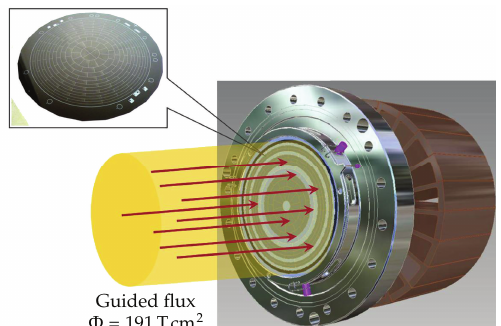
Figure 24: Schematic view of the detector. The electrons are guided along magnetic field lines to the sensitive area of the detector, which has a diameter of 10cm. The inset shows a photograph of the detector, in which the 148 pixels are